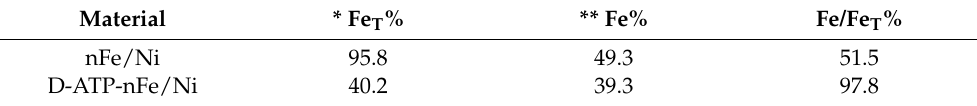
Table 2. Percentage of Fe/Fe T in nFe/Ni and